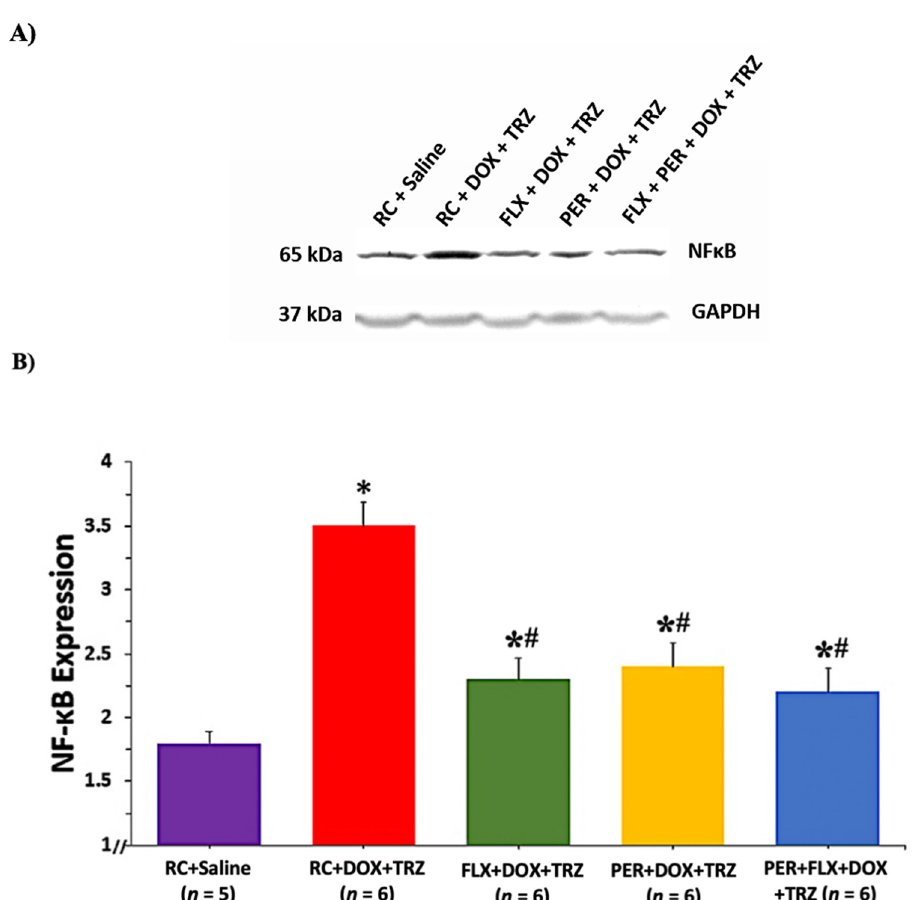
Figure 6. Changes in NF-kB expression in mice prophylactically treated with FLX, PER, or FLX + PER treated with DOX + TRZ. ( A ) Representative Western blot; ( B ) C57Bl/6 female mice treated with RC + DOX + TRZ demonstrated a significant increase in NF- κβ expression at week 6. Prophylactic treatment with FLX, PER, or FLX + PER significantly attenuated elevations in NF- κβ expression associated with DOX + TRZ administration. Data are expressed as mean ± SEM. * p < 0.05 RC + DOX + TRZ vs. RC + saline. * # p < 0.05 FLX + DOX + TRZ or PER + DOX + TRZ, or FLX + PER + DOX + TRZ